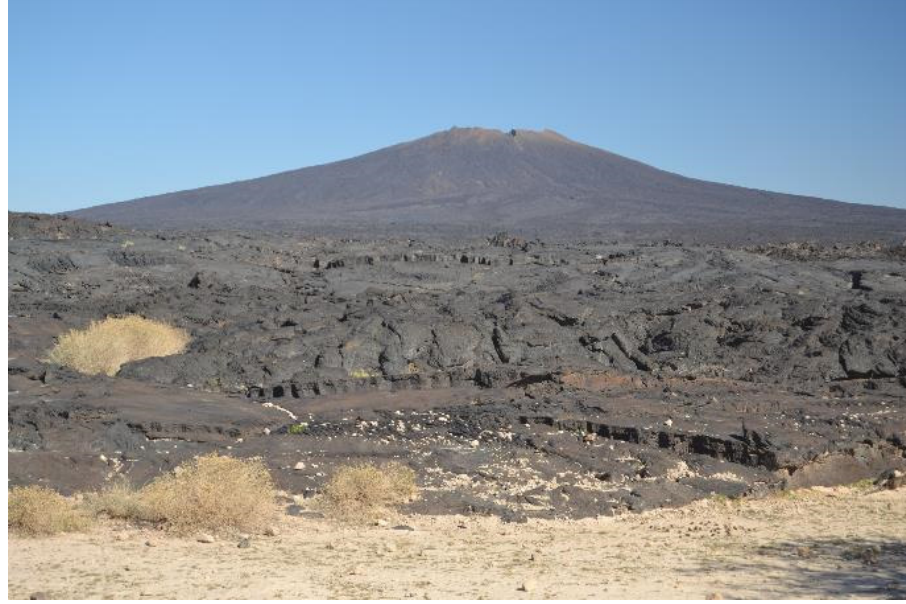
Figure 10. The eastern foothill of Jabal Quidr (about 2.3 km from source) with inflated, vesicular p ā hoehoe sheets.